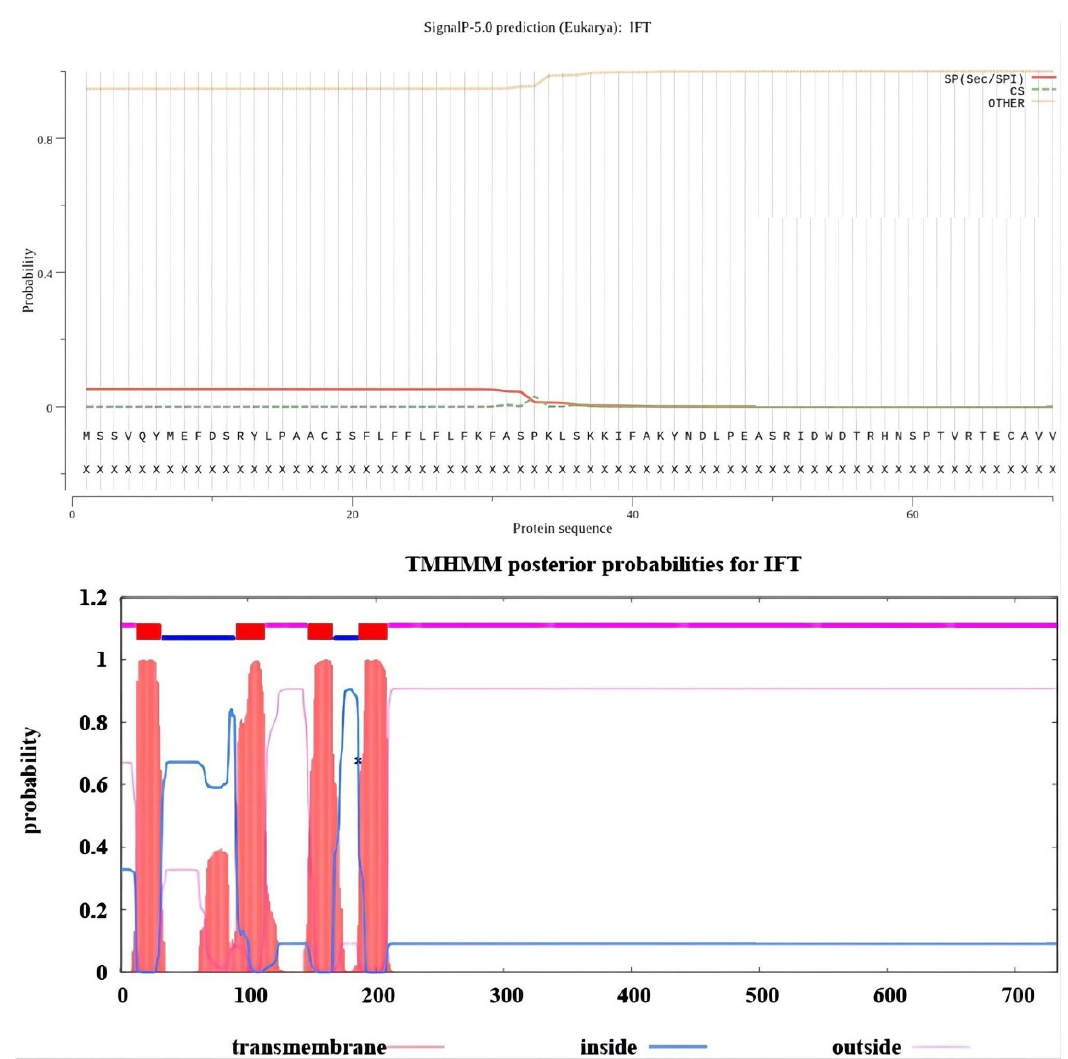
Figure A2. The oIFT signal peptide and transmembrane domain prediction results. The probability of a signal peptide presented in the IFT amino acid sequence is also extremely low (0.0528), so it is assumed that no signal peptide is present in this protein either. The predicted transmembrane domains show that amino acids 1–12, 114–146, and 210–733 are outside the cell. The amino acids 13–32, 91–113, 147–166, and 187–209 are in the transmembrane domain, and the amino acids 33–90 and 167–186 are in the intracellular domain. Table A1. Primer sequences used for qPCR.